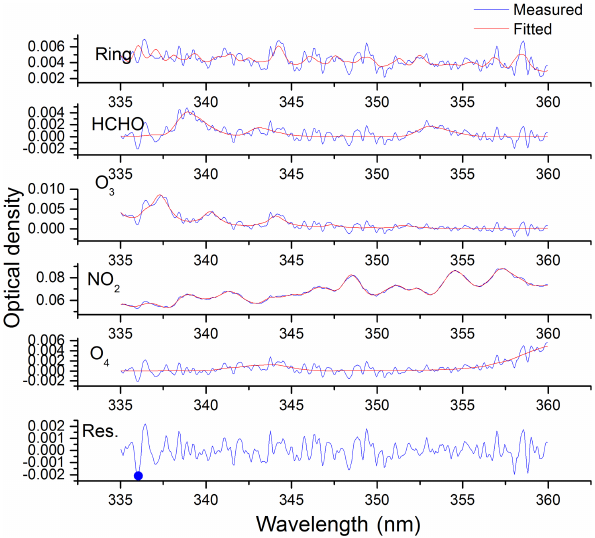
Figure 5. Example of a DOAS fit of a spectrum to retrieve the dif- ferential slant column densities of HCHO; the red and blue curves indicate the fitted absorption structures and the derived absorption structures from the measured spectra, respectively.